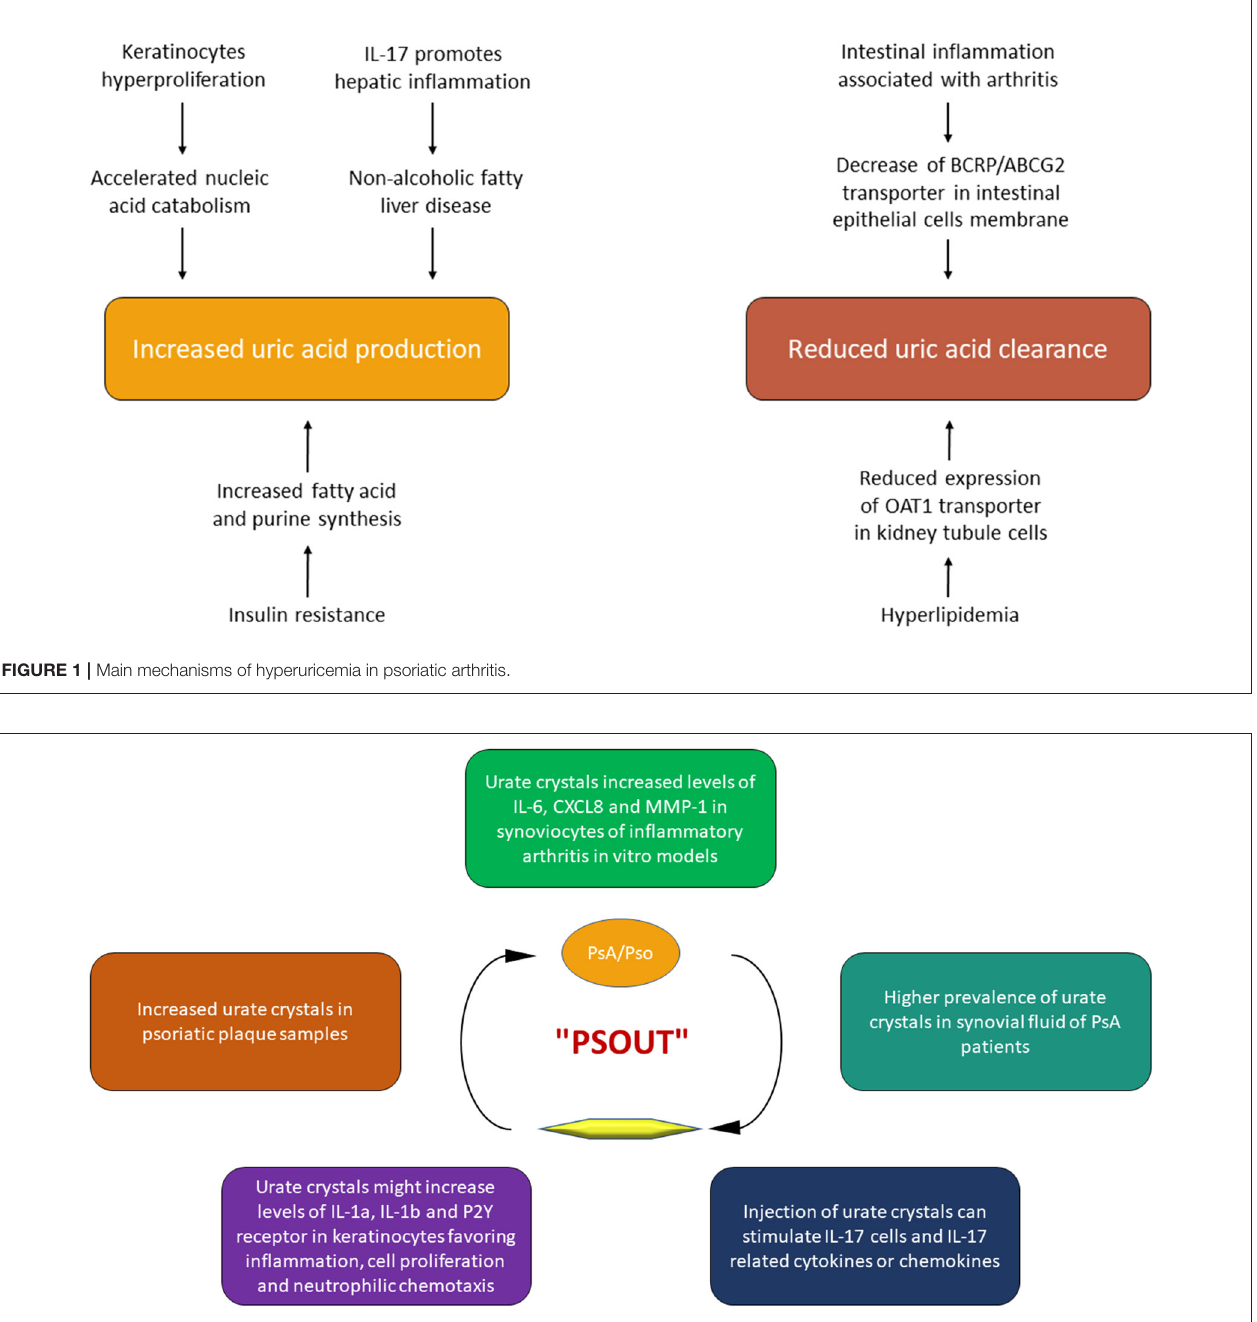
healthy and rheumatoid arthritis subjects, demonstrated that monosodium urate crystals were able to increase the production of inflammatory mediators such as IL-6, CXCL8 and matrix metalloproteinase-1 (72,